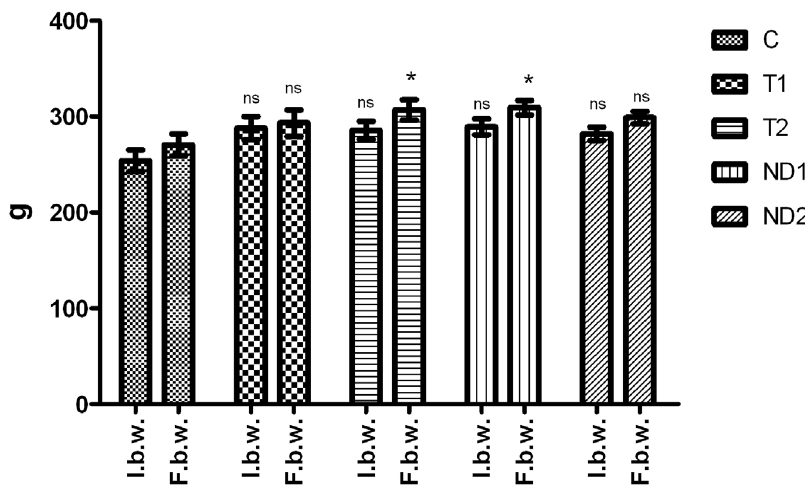
Figure 1. The body weight in the experimental groups (g) before and after the administration of androgen substances.